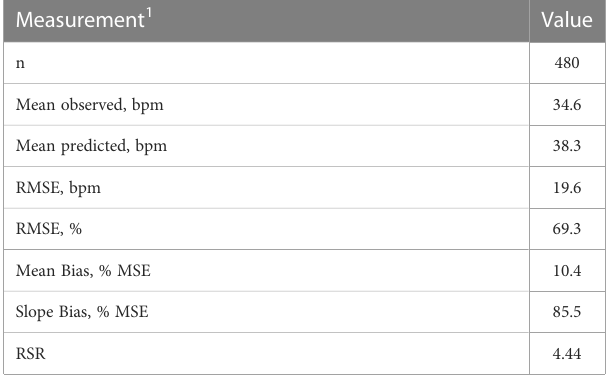
TABLE 1 Descriptive statistics for the comparison of sensor-measured heart rates and heart rates determined manually. Measurement 1